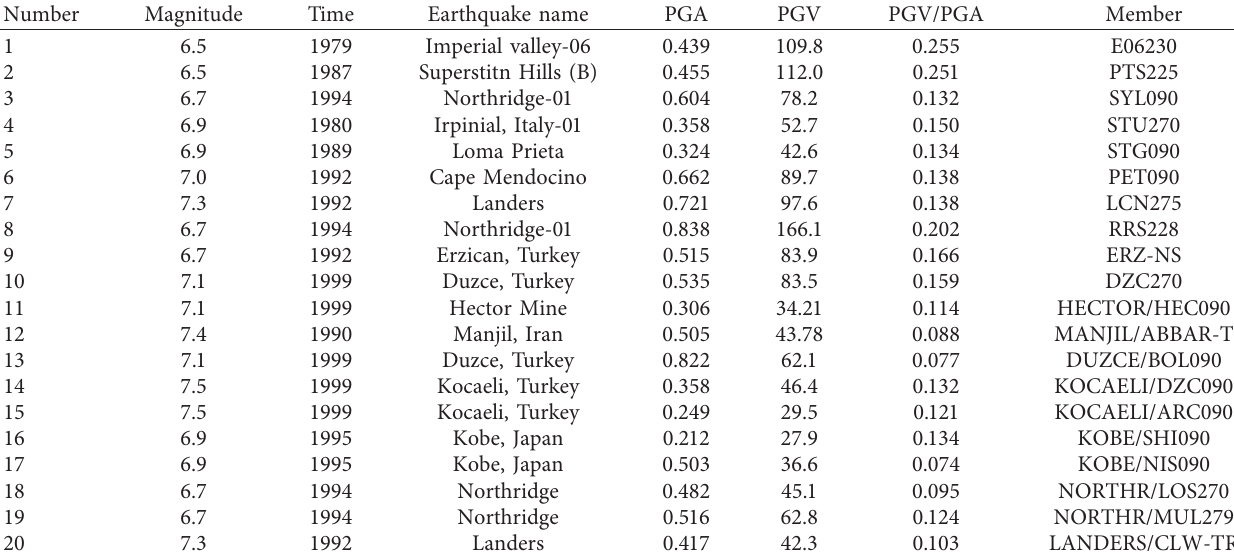
Table 2: Information of the selected seismic ground motions.